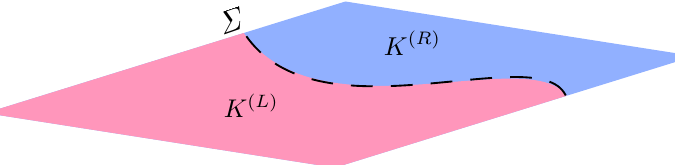
Figure 1 . Two topological phases separated a codimension one defect (cid:6). The time dimension has been suppressed